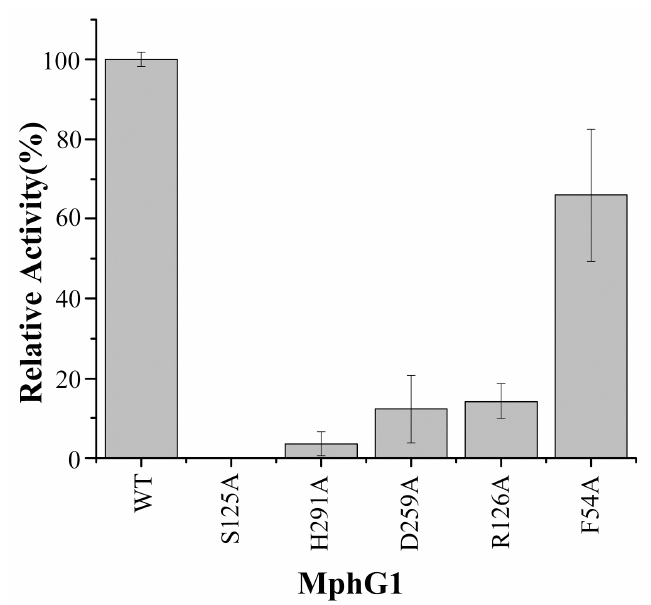
Figure 7. Relative activities of wild type and mutants of MphG1.